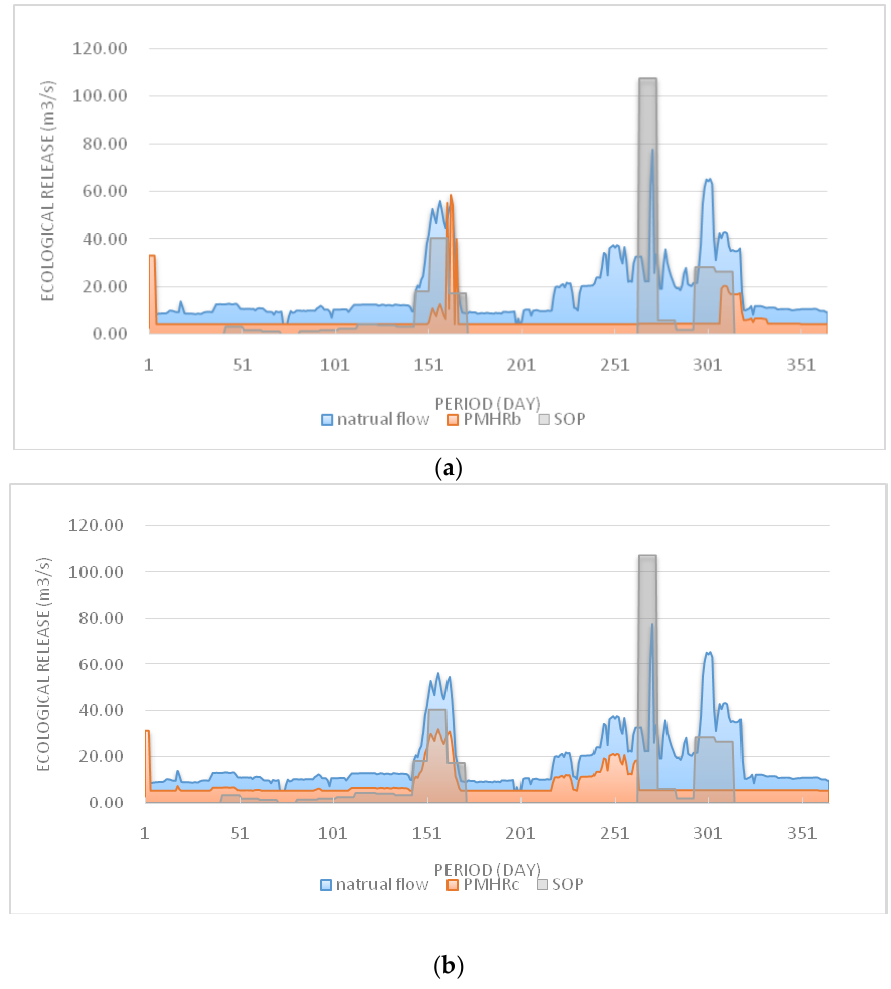
Figure 6. Comparison of release processes between different operating rules, calculated by expectation. ( a ) Comparision of release process of natural flow, PMHR B and SOP; ( b ) Comparision of release process of natural flow, PMHR C and SOP.